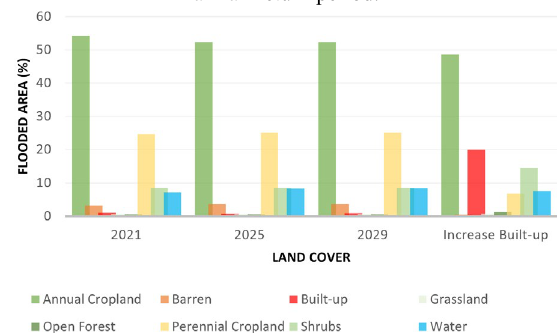
Figure 13. Flooded areas for each land cover with a 2-year rainfall return period.